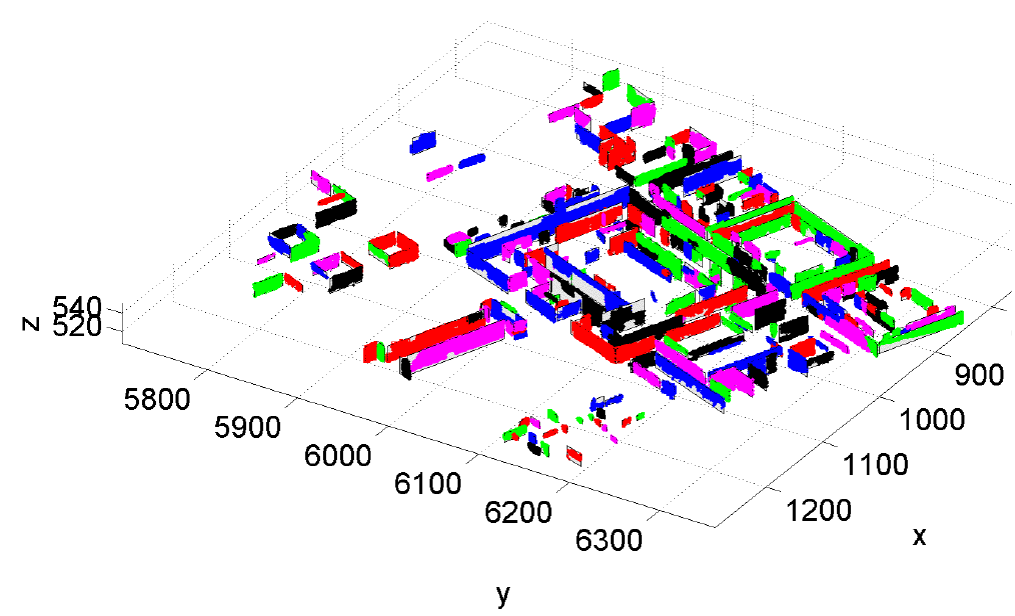
Figure 8. Segments with more than 100 points found by the regiongrowing